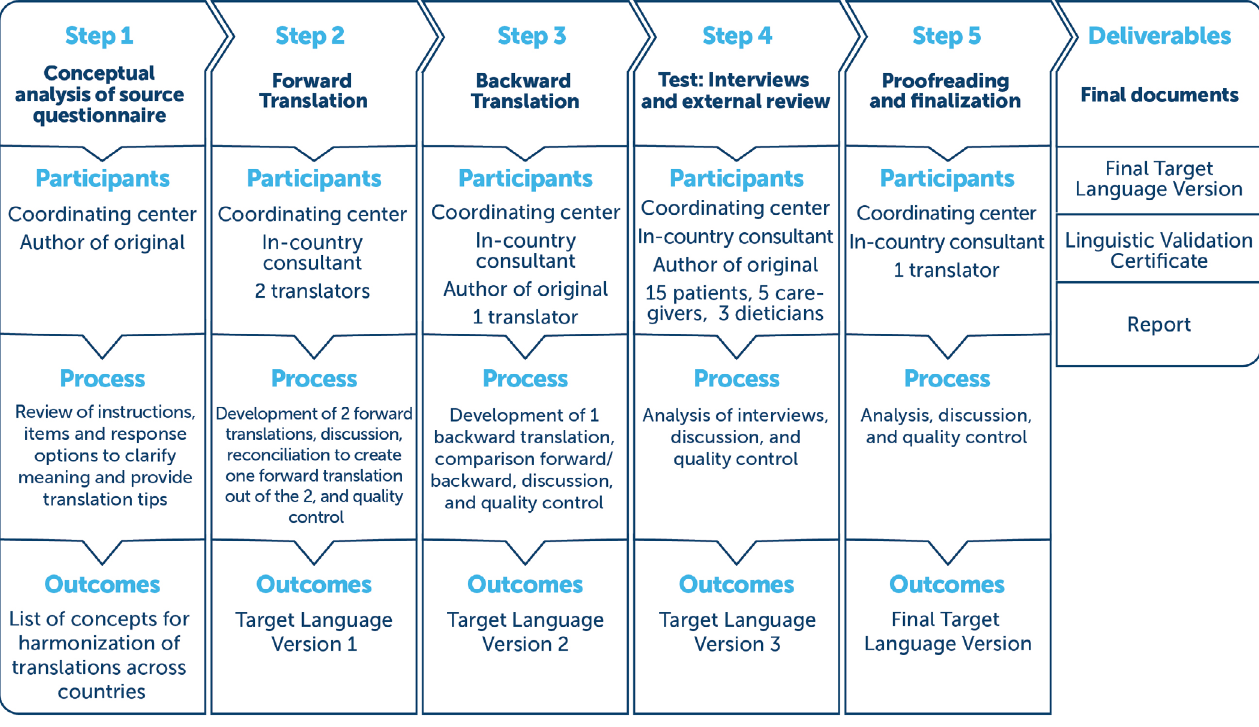
Figure 1. Linguistic Validation Process individual interviews with patients and caregivers. The objective was to investigate the appropriateness, understandability and clarity of the Brazilian Portuguese PKU-QOL